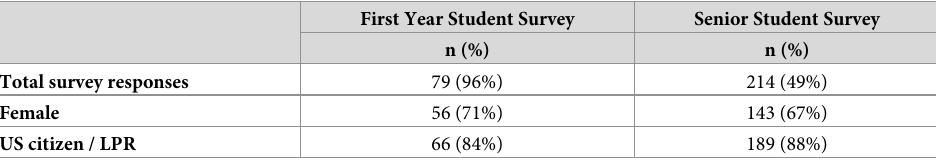
Table 1. Summary of survey